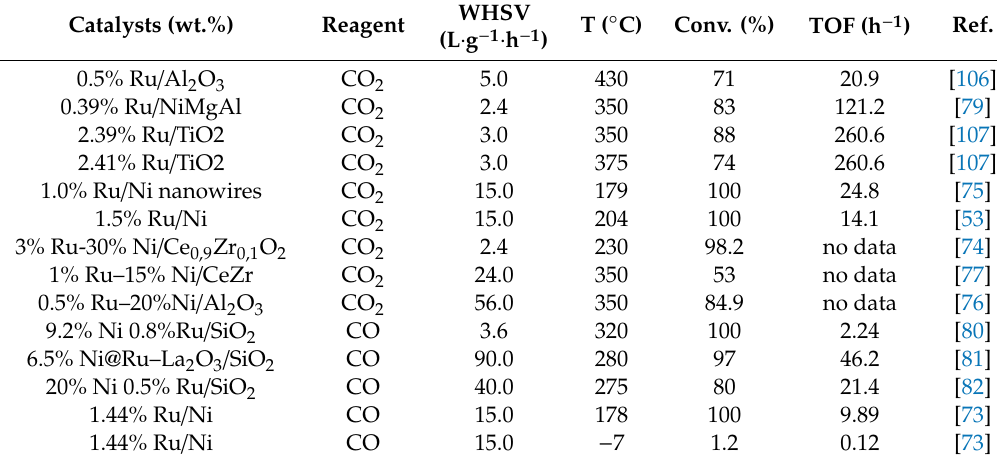
Table 3. Ru-Ni catalysts for low-temperature methanation of CO or CO 2